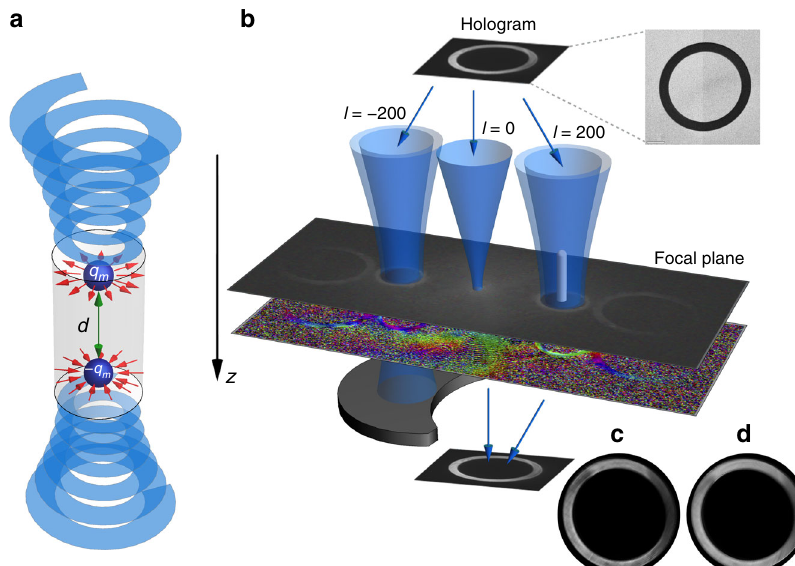
Fig. 3 Schematic illustration of the set-up used for measuring an out-of-plane magnetic fi eld. a Schematic diagram of the interaction of a twisted electron beam with a magnetic dipole comprised of two magnetic monopoles separated by a distance d with opposite charges of q m and − q m . The red arrows represent the magnetic fi elds induced by the magnetic monopoles. b An amplitude-phase hologram that is comprised of an annular ring with a structured pitch-fork mask — its energy fi ltered transmission electron microscope image is shown in the inset — is illuminated by a beam of electrons. .Scale bar represents 5 μ m. Only electrons traversing throughout the annular region gain phase, and are absorbed by the mask elsewhere. The 0th, 1 st , and − 1 st order diffracted electrons carry OAM values 0, 200, and − 200, respectively. The diffraction orders become spatially distinct in the focal plane, where experimentally measured probability and phase distributions for the electron are shown in the top and bottom plane , respectively. Therefore, they constitute two arms of an interferometric-type apparatus. A magnetic pillar generating a longitudinal magnetic fi eld along the propagation direction of the electrons acts as a phase shifter, given that the fi rst-order diffracted electron carries a high OAM. The beams are then coherently recombined in the image plane of the hologram where the interference patterns are shown c with and d without the pillar. The interference of the 0th, 1 st ( − 1 st ) orders is recorded, and a shift in the fringes of the interference pattern is observed as the magnetic pillar is brought in and out the path of the 1 st ( − 1 st ) order diffracted